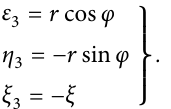
ξ η . (b) Coordinate system ε 1 1 1